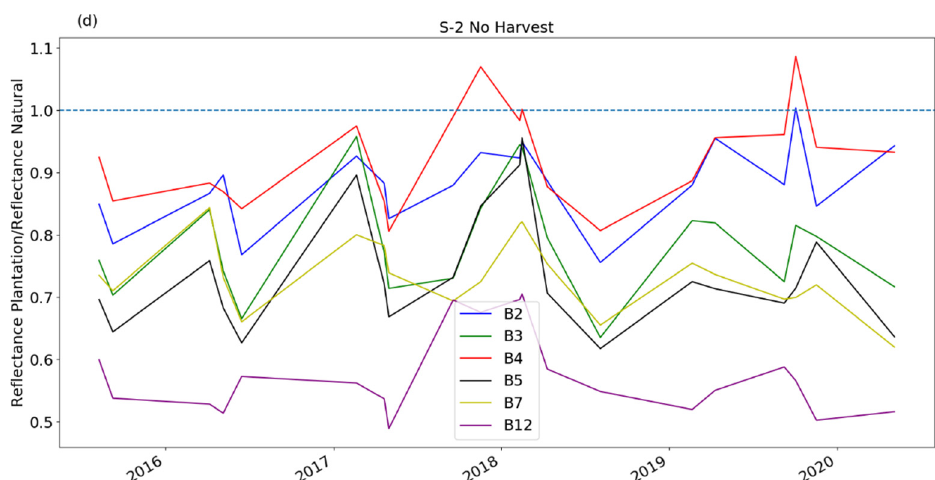
Figure 3. A time series from 2015 to 2020 showing the ratio of the mean plantation band values to the mean natural forest band values for a group of plantations harvested in April 2016 ( a , c ) and a control group that was not harvested in the study period ( b , d ), for both Sentinel-1 ( a , b ) and Sentinel-2 ( c , d ). Shaded red vertical column shows period in which the selected plantations were harvested. For clarity we do not show all the S-2 bands: only the visual bands (blue (B2), green (B3) and red (B4)), two Near Infra-red (NIR) bands (B5 and B7) and a short-wave infrared (SWIR) band (B12) are shown. The other NIR bands (B6, B8, B8A) behave similarly to B7. The other SWIR band (B11) behaves similarly to B12.